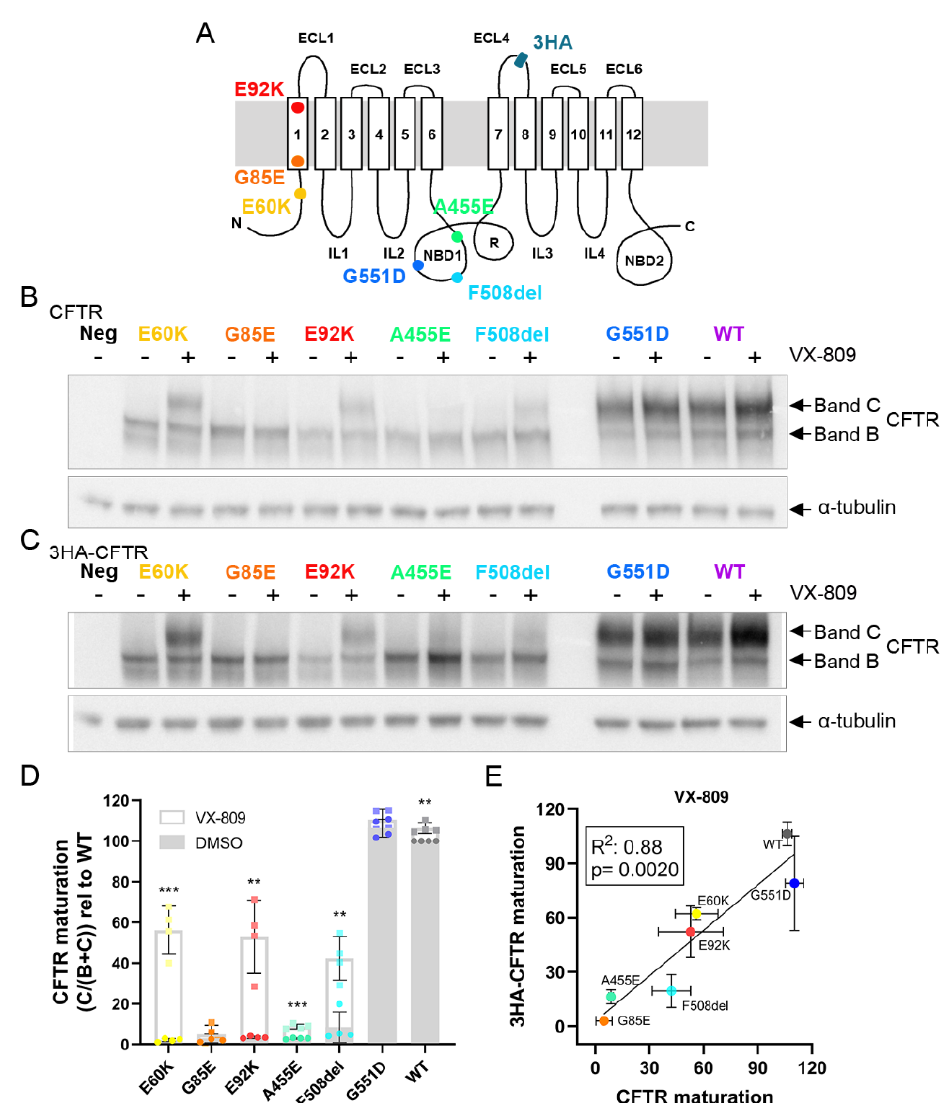
Figure 1. Assessment of CFTR maturation of rare CFTR mutants and their response to corrector VX-809. ( A ) Schematic CFTR protein structure adapted from reference [21], depicting the (rare) CFTR mutants studied and the localization of the 3HA tag in the fourth extracellular loop [17]. Western blot analysis of ( B ) untagged and ( C ) 3HA-tagged CFTR variants by anti-CFTR antibodies and α-tubulin (loading control) in whole-cell lysates of stably transduced HEK293T cells. The lower band (‘band B’) represents immature, core-glycosylated CFTR, the upper band (‘band C’) the complex glycosylated, fully mature protein. ( D ) Rescue in CFTR maturation (without tag) by corrector VX-809 (2.5 µM, 24 h) expressed as the increase in band C over total (B + C) CFTR relative to WT. Dots (DMSO) and squares (VX-809) represent independent experiments, one of which is shown in (B). ( E ) Pearson correlation of the rescue in CFTR maturation by corrector VX-809 of untagged and 3HA-tagged CFTR variants, as quantified in (D). Graphs depict the mean ± S.D. of three (3HA − tagged) or four (untagged) independent experiments. VX-809 rescue over DMSO was compared for each mutant by multiple t-testing. ** P < 0.01, *** P < 0.001. ER: endoplasmic reticulum, 3HA: triple hemagglutinin, ECL: extracellular loop, IL: intracellular loop, NBD: nucleotide binding domain, MSD: membrane spanning domain, R: regulatory domain, LV: lentiviral vector.